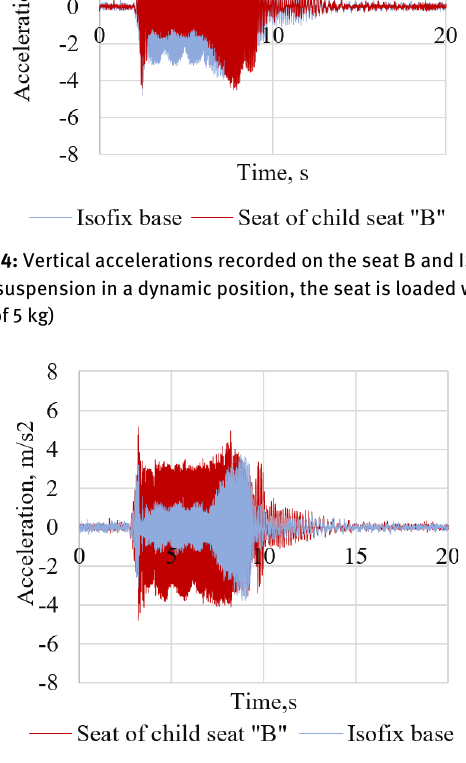
Figure 5: Vertical accelerations recorded on the seat B and ISOfix base (suspension in a raised position, the seat is loaded with a mass of 5 kg)